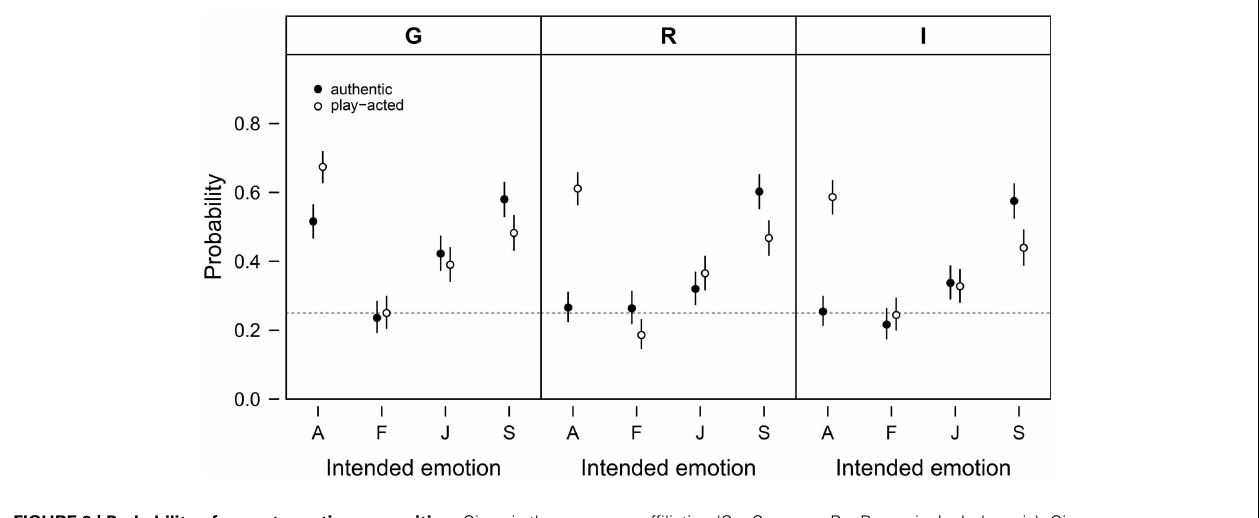
FIGURE 3 | Probability of correct emotion recognition. Given is the probability of correct emotion recognition with respect to the intended emotion (A – anger, F – fear, J – joy, S – sadness) and stimulus authenticity (authentic or play-acted).The data are split by cultural